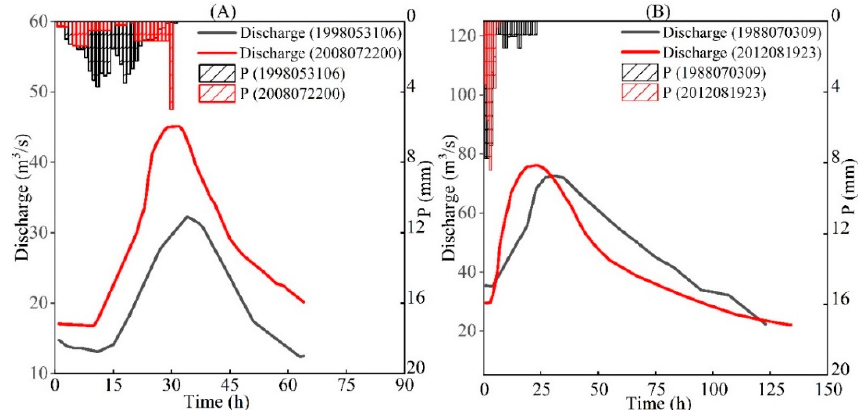
Figure 7. Two groups of su ffi cient runo ff data of rain and heavy rain which precipitation center in ZY, GC, EQ in di ff erent periods of urbanization were selected to analyze the impact of urbanization on hydrological process by statistical three indexes, namely peak lag, flood peak and runo ff coe ffi cient. The results are shown in Tables 5–7.